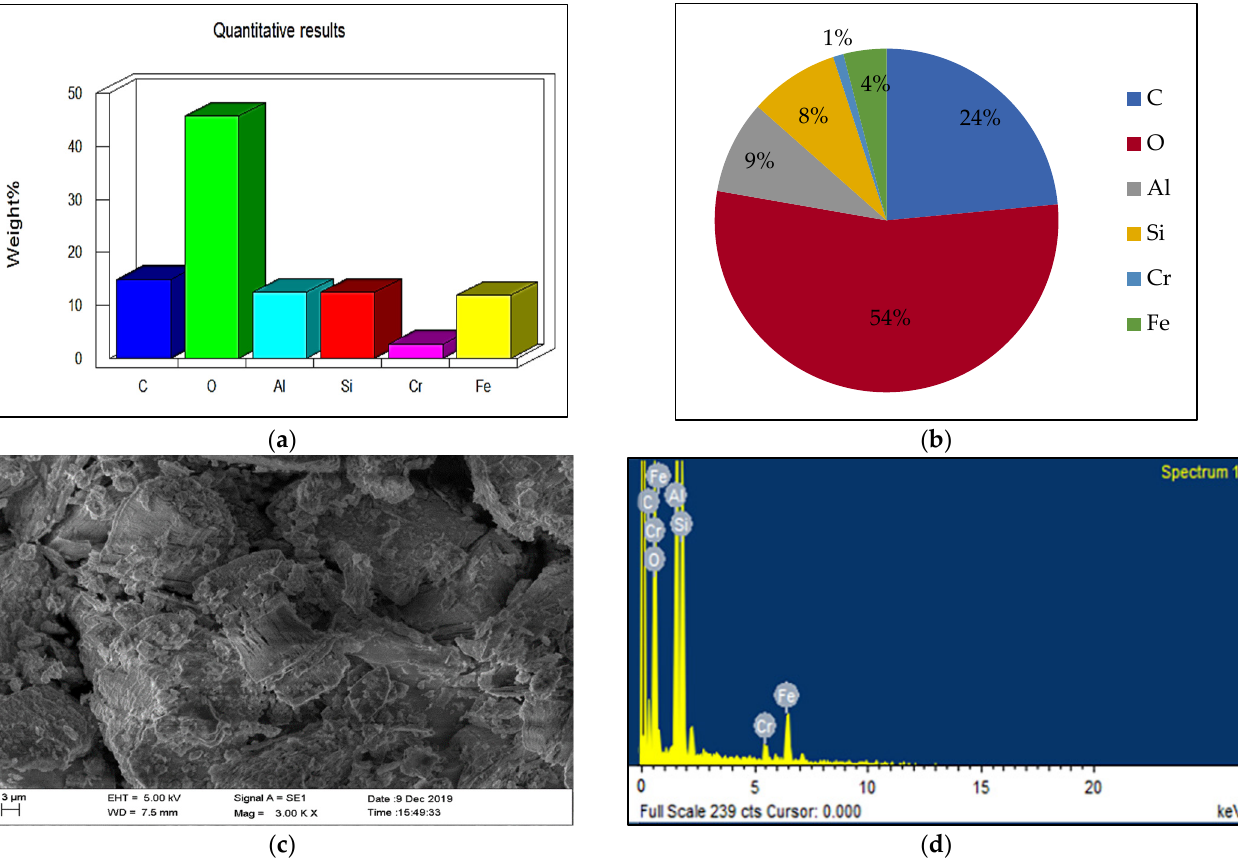
Figure 5. EDS analysis of Alevoor sample; ( a ) elements weight (%), ( b ) atomic weight (%), ( c ) SEM image, ( d ) spectrum image.